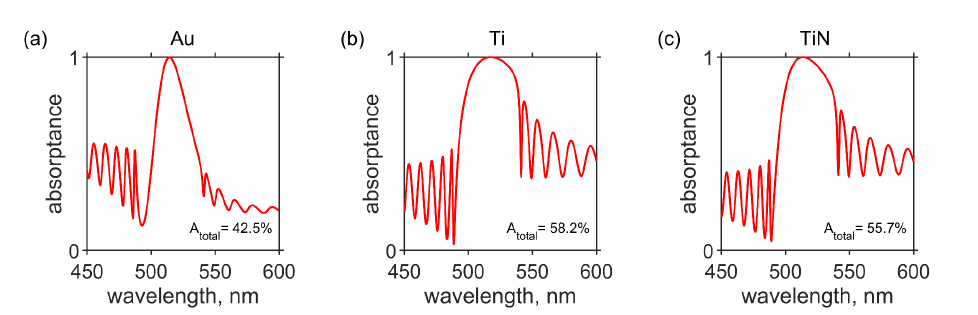
Figure 5. Absorptance spectra of the investigated structure consisting of the PC conjugated with ( a ) the gold, ( b ) titanium, and ( c ) titanium nitride film. The corresponding total absorptances are shown in the lower right-hand corner. Metal thicknesses are the same as in Figure